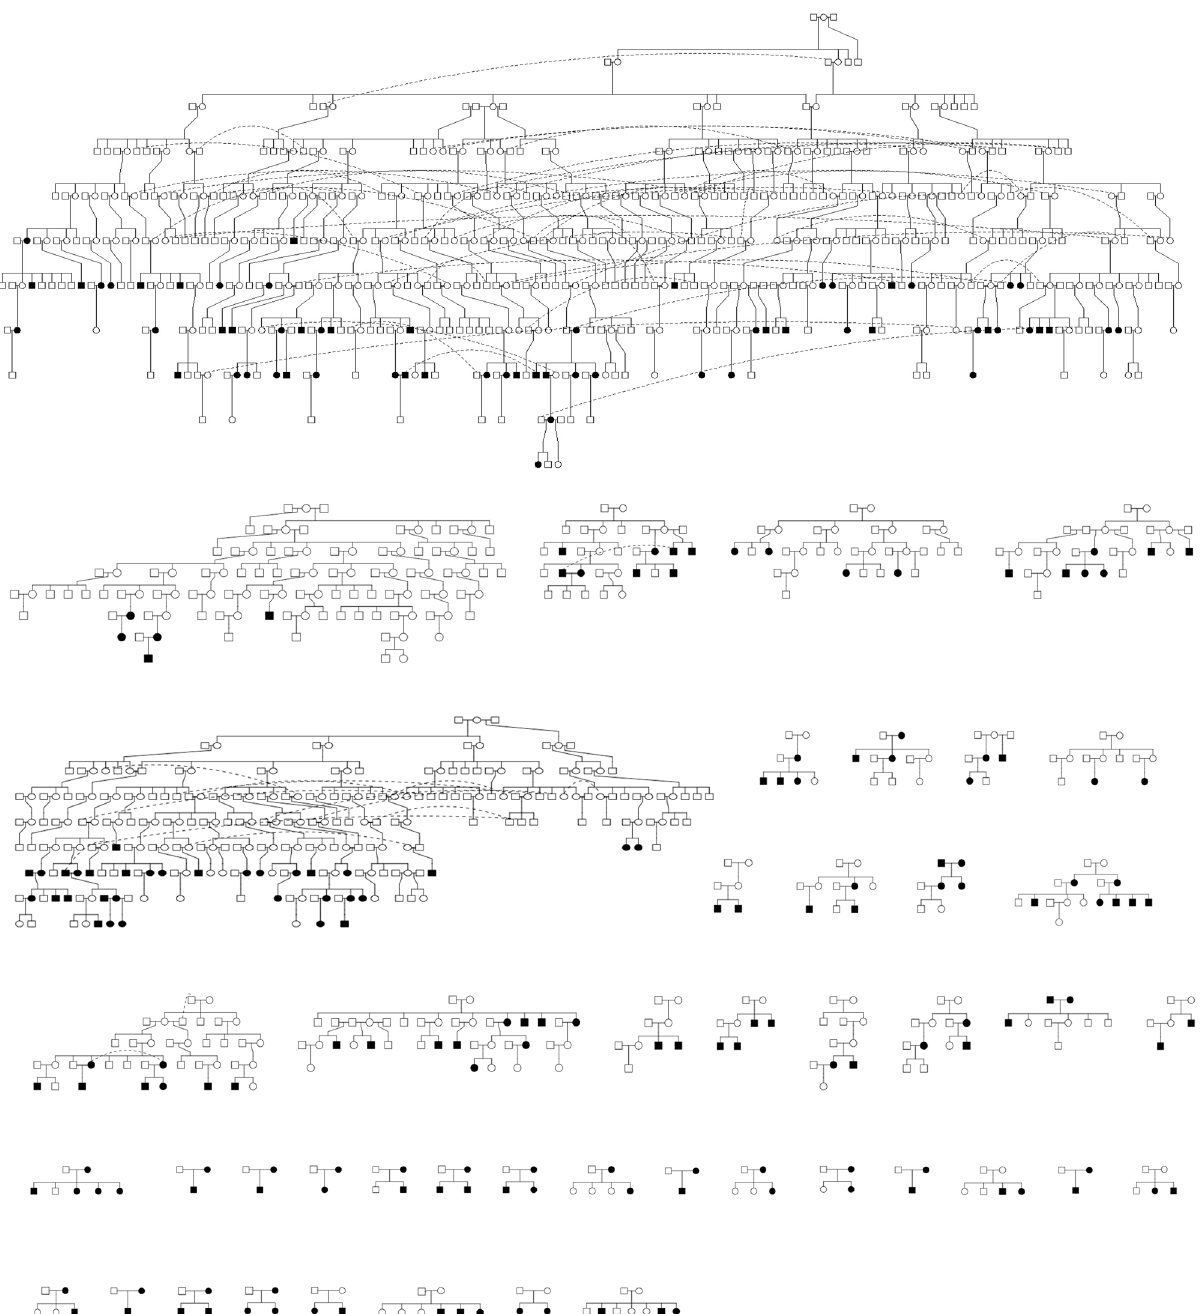
Figure 2. Forty-five maternal pedigrees relating to the sampled individuals examined in this study. Individual pedigrees were established for forty-five founding mothers from the Norfolk Island Core Pedigree (Fig. 1). Individuals whose mtDNA was sequenced are shown as blackened circles (females) or squares (males) and are from the lower four generations of the Norfolk Island Core Pedigree (Fig. 1). Pedigrees were generated using the Pedigree v1.4 54 , Kinship2 v1.8.5 55 and Tidyverse v1.3.1 56 packages in RStudio v1.4 57